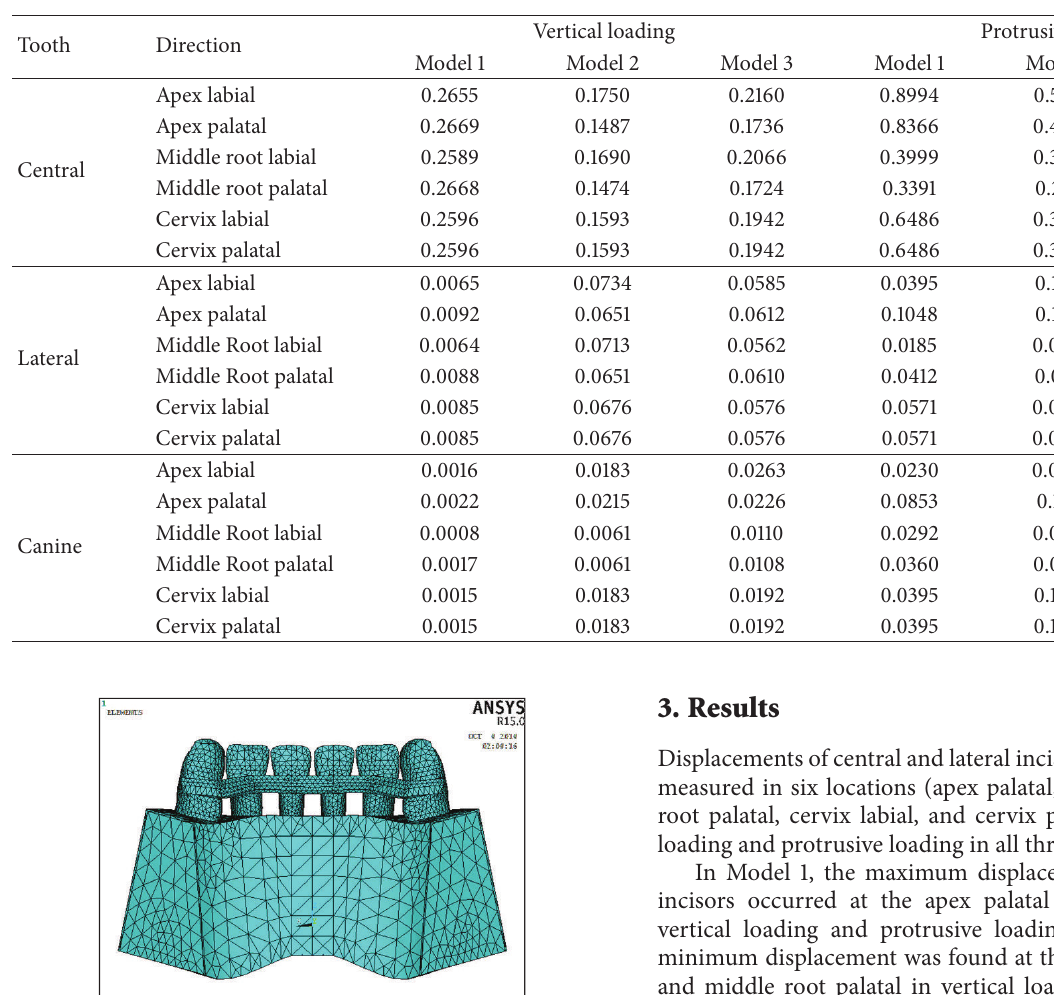
Table 2: Model 1 to 3 displacement data (in millimeters).